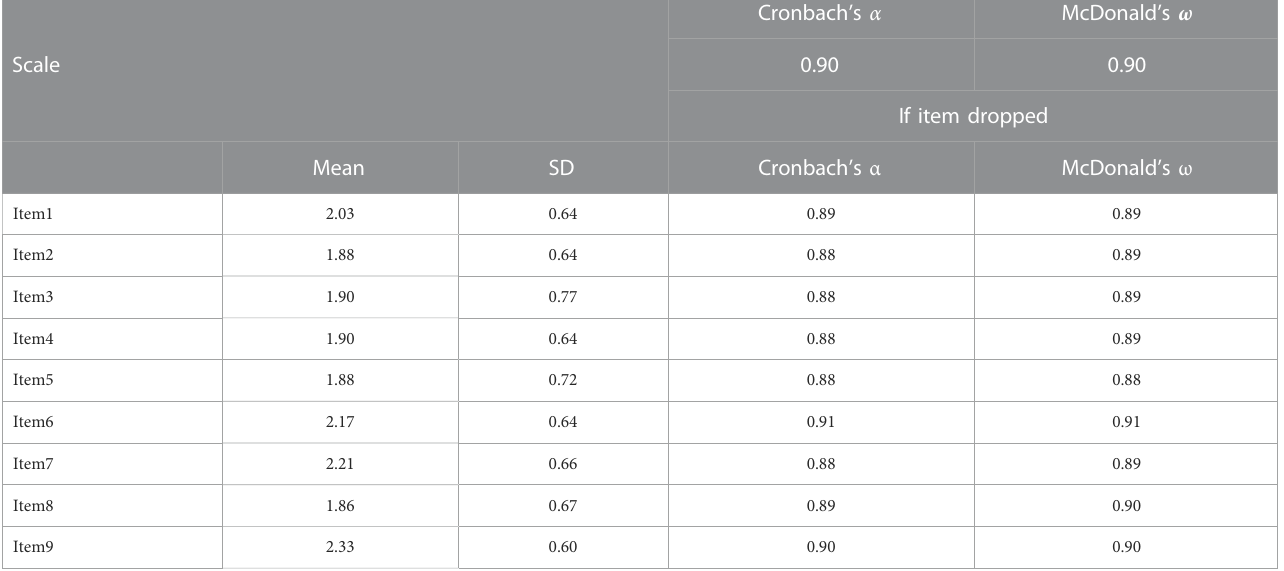
TABLE 2 Scale and item reliability statistics (N = 143).